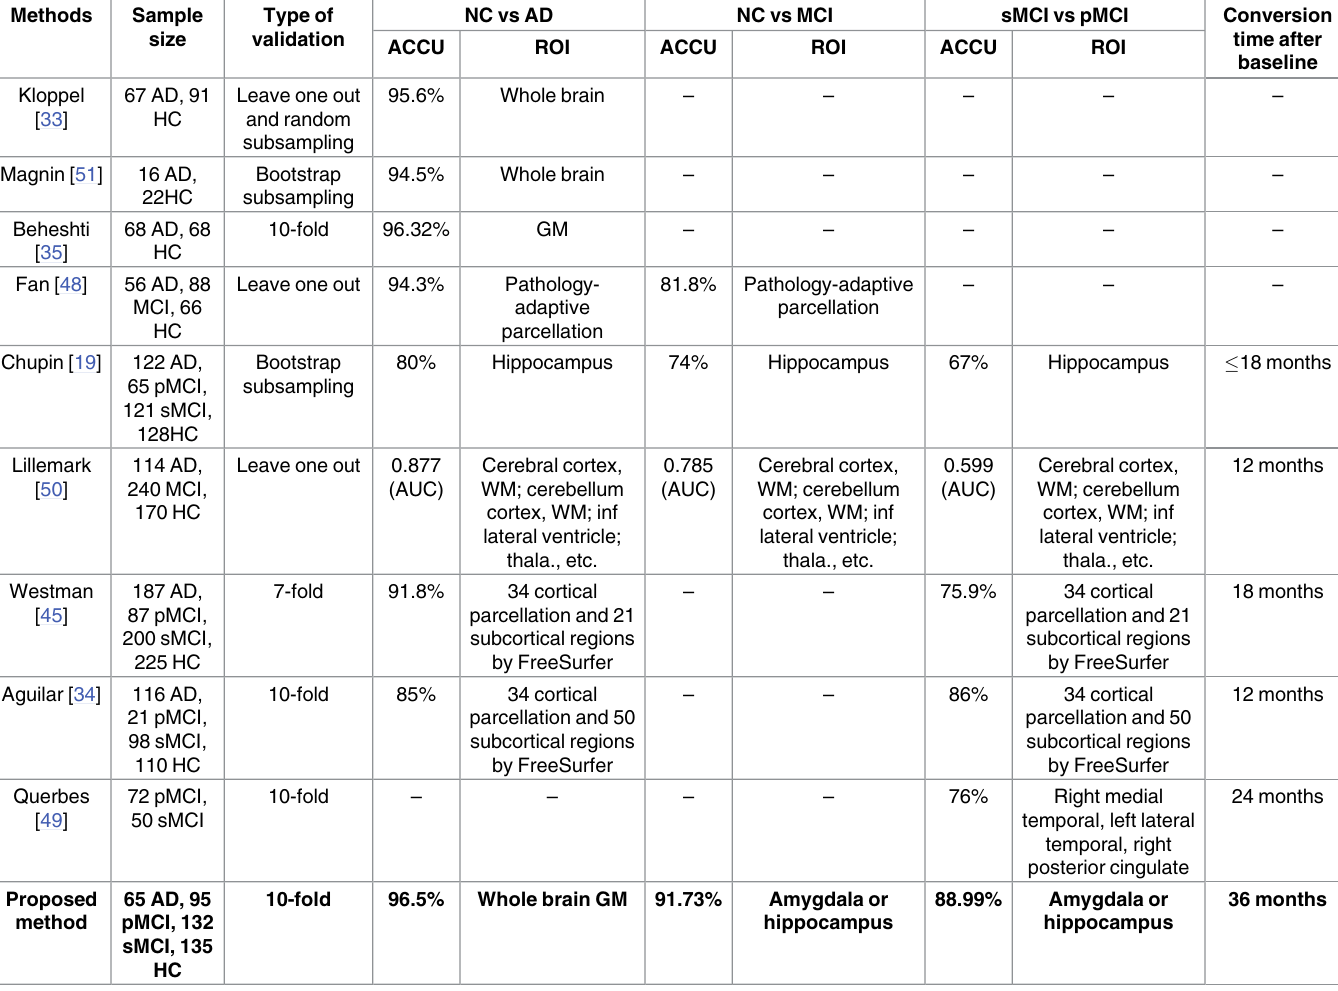
Table 6. Comparison between the proposed method and existing